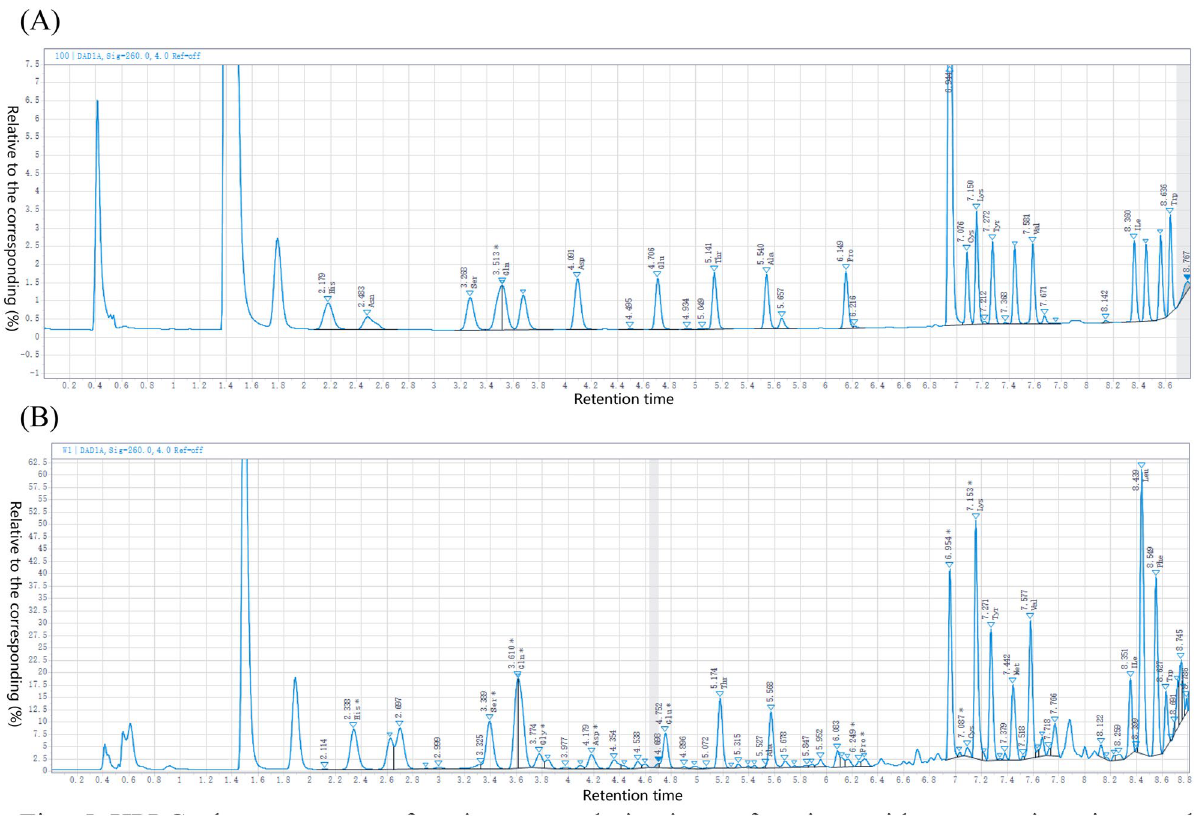
Figure 1. HPLC chromatogram of aminoenone derivatives of amino acids, ammonium ion, and biogenic amines at 280 nm. Standard solution ( A ); Representative sample ( B ). Met, Methionine; Val, Valine; ILE, Isoleucine; Leu, Leucine; Phe, Phenylalanine; Trp, Tryptophan; Lys, Lysine; Thr, Threonine; His, Histidine; Asn, Asparagine; Ser, Serine; Gln, Glutamine; Arg, Arginine; Gly, Glycine; Asp, Aspartic acid; Glu, Glutamic acid; Ala, Alanine; Pro, Proline; Cys, Cysteine; Tyr,